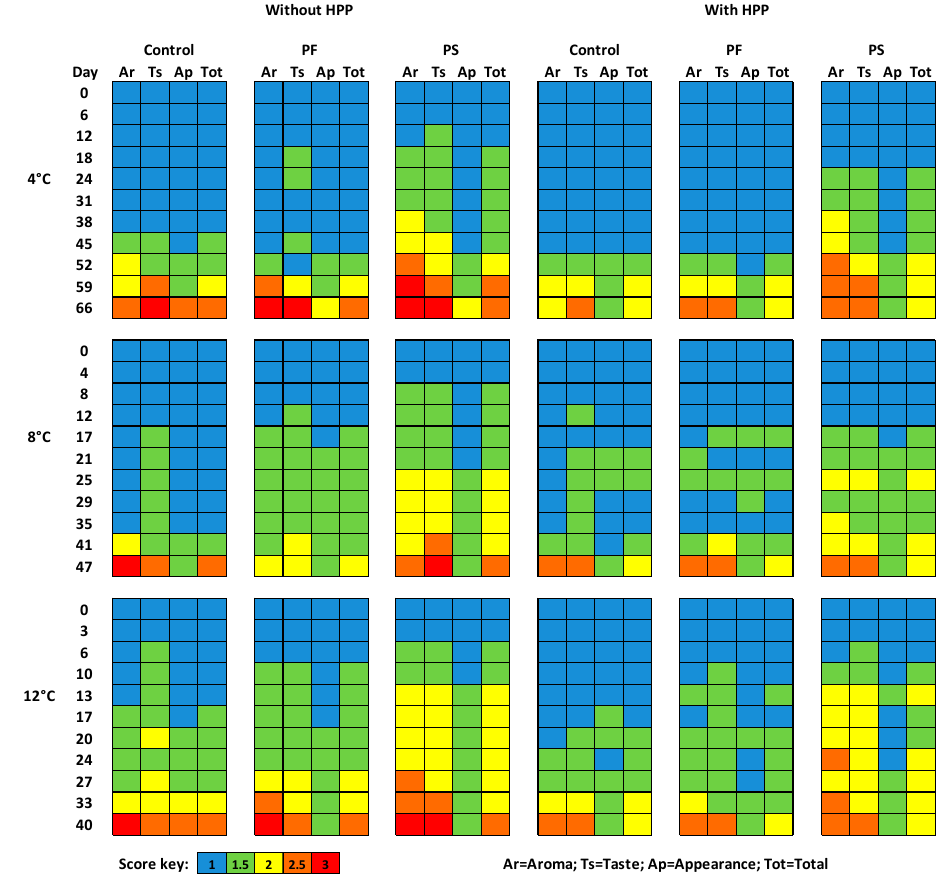
Figure 4. Sensory scores for ham slices treated or not with HPP, during storage at 4, 8 and 12 °C. The “Total” value represents the mean value of aroma, taste and appearance of each sample rounded to the closest value.